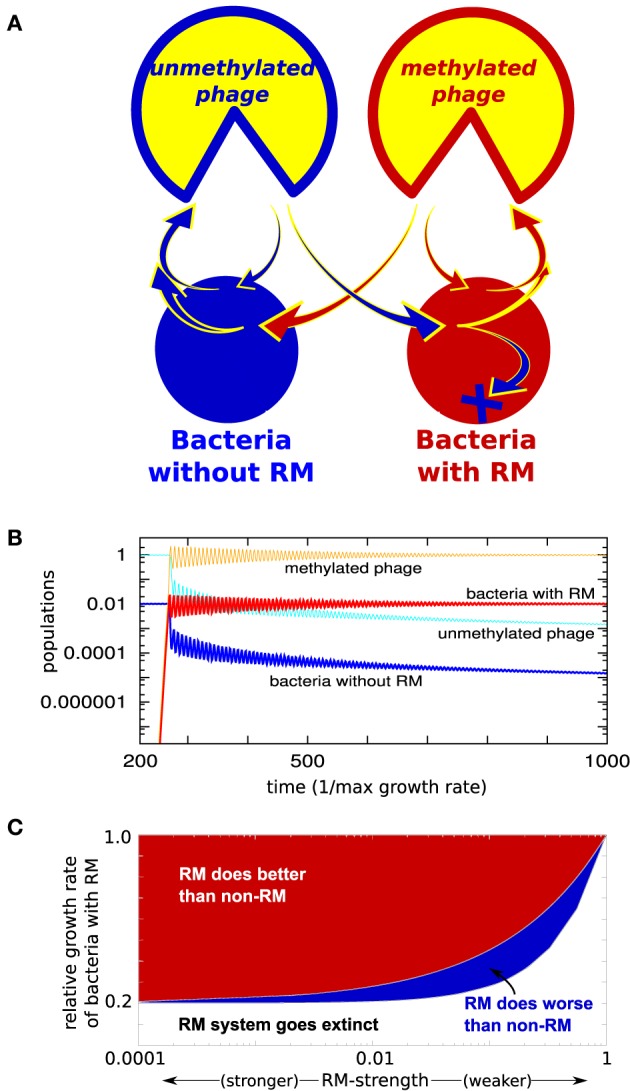
(A) Model: Two bacterial strains exposed to one phage type. One of the strains has an RM system. (B) Simulation where the “red” strain with weak RM system with ω1 = 0.1 is introduced to the “blue” undefended strain (ω0 = 1) at time = 250 (measured in units of maximal bacterial growth rate). (C) Coexistence of the two bacteria as function of the growth rate of the RM strain, and strength of its RM system, when dilution rate α = 0.2, η = 1, and growth rate of blue strain γ0 = 1. As long as growth rate of the RM strain satisfies, γ1/γ0 < α +(1-α)ω1, the RM system will survive. And if γ1/γ0>α+(1−α)ω1, then the RM system does better than the non-RM system (see Section 3 of Supplementary Material).